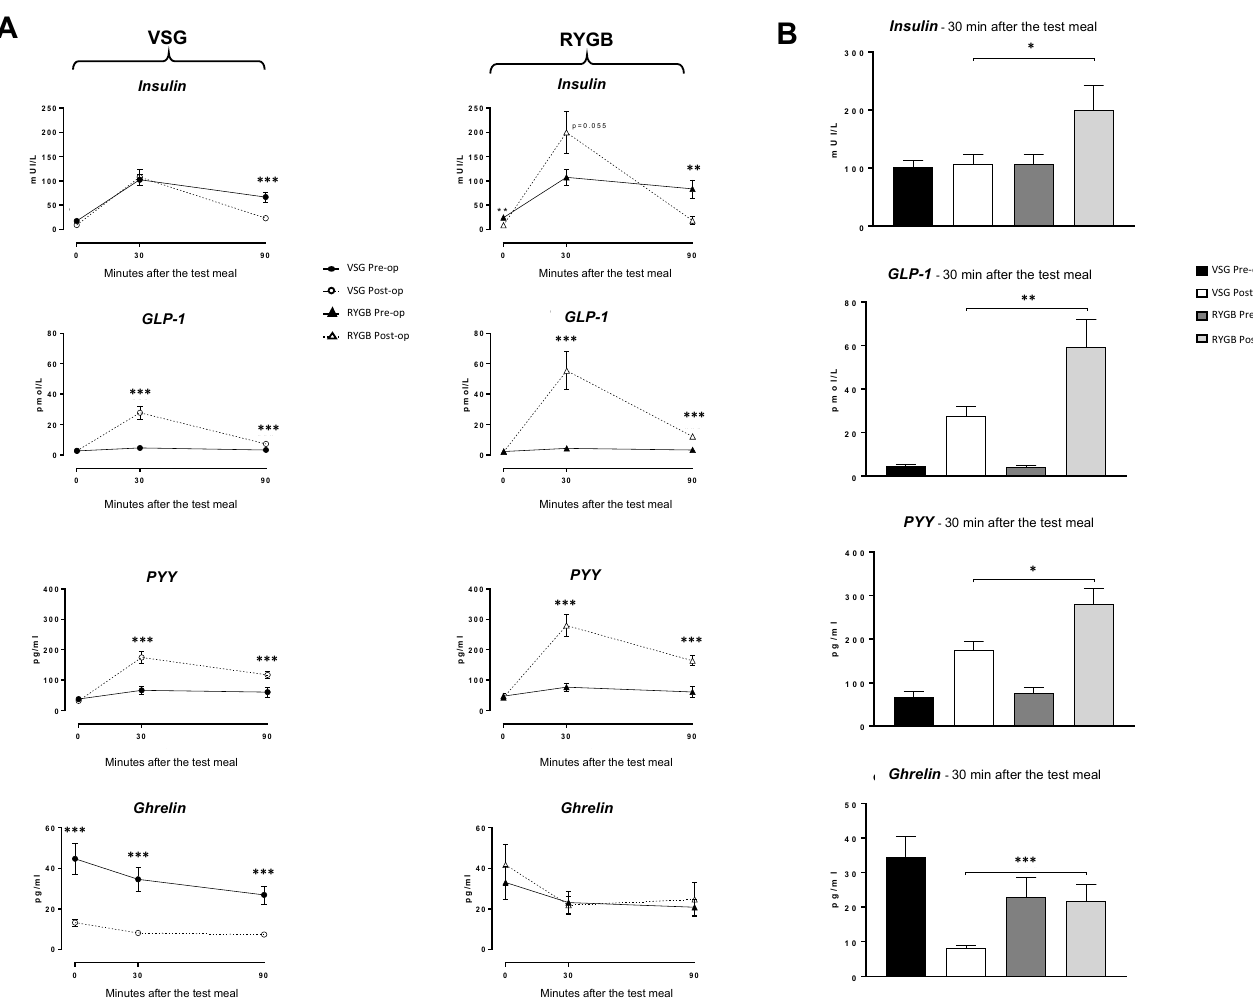
Figure 4. Plasma levels of appetite-regulating peptides following a test meal before (pre-op) and 6 months after surgery (post-op). ( A ) Kinetics of endocrine response. ( B ) Comparison of plasma endocrine levels 30 min (t30) after the test meal in patients who underwent a vertical sleeve gastrectomy (VSG) or a Roux-en-Y gastric bypass (RYGB). Glucagon-like peptide (GLP-1); peptide YY (PYY). *, p < 0.05; **, p < 0.01; ***, p < 0.001.